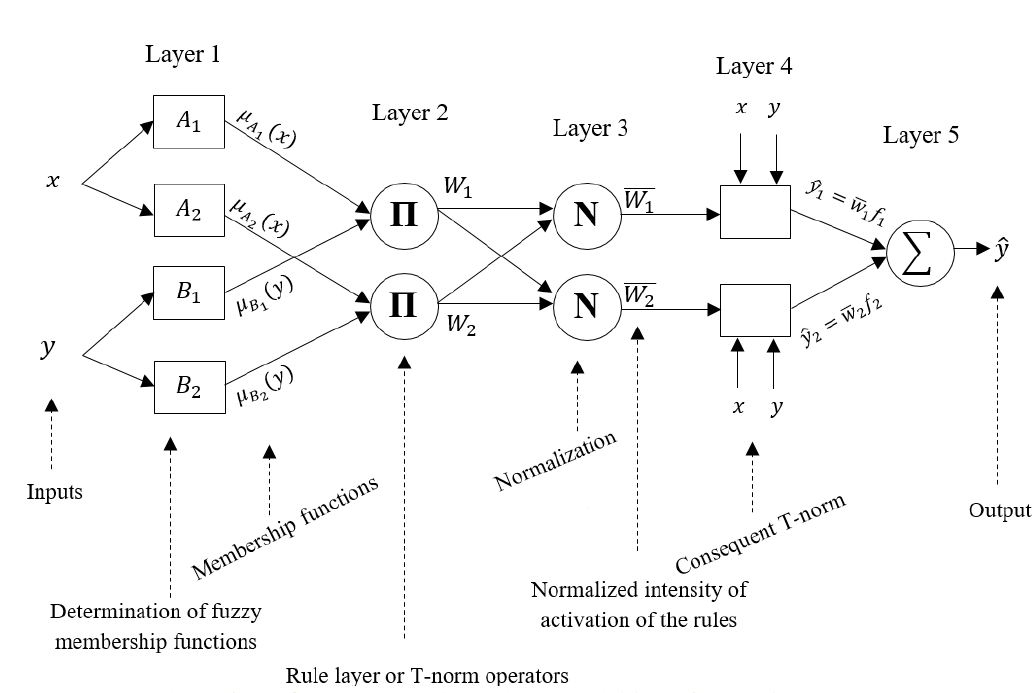
Fig. 3. ANFIS structure with two input variable and two